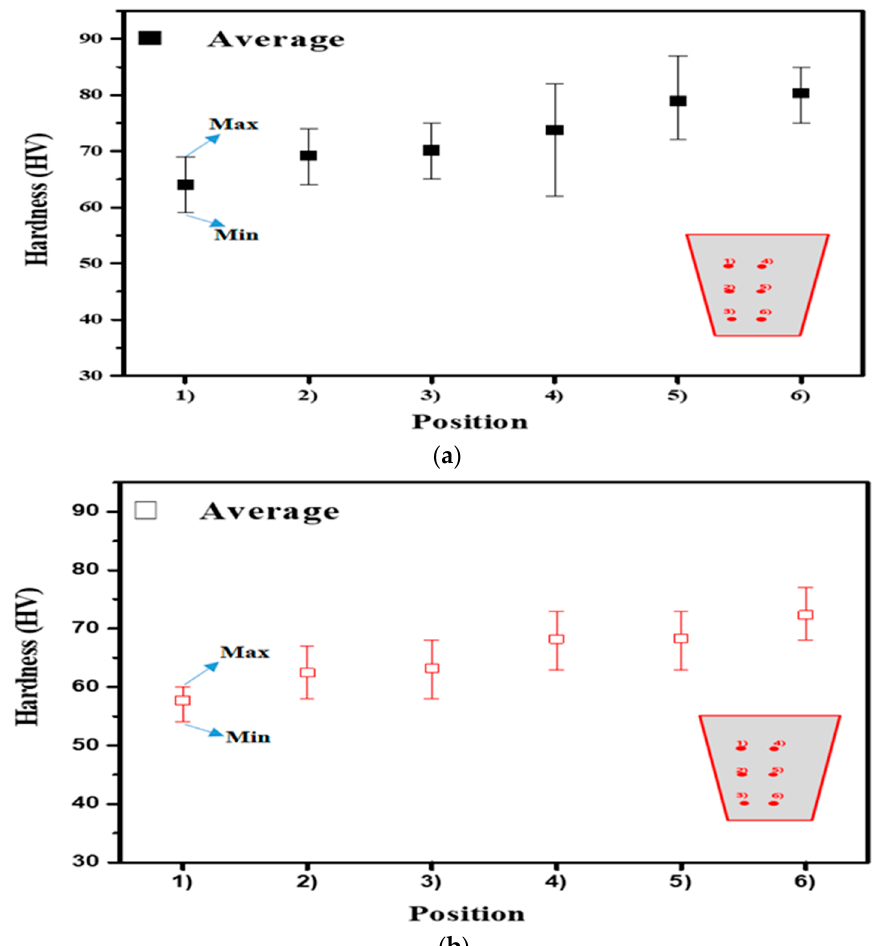
Figure 9. Vickers hardness of A356 semi-solid slurry at different positions: ( a ) CMSP; ( b ) CAMP.